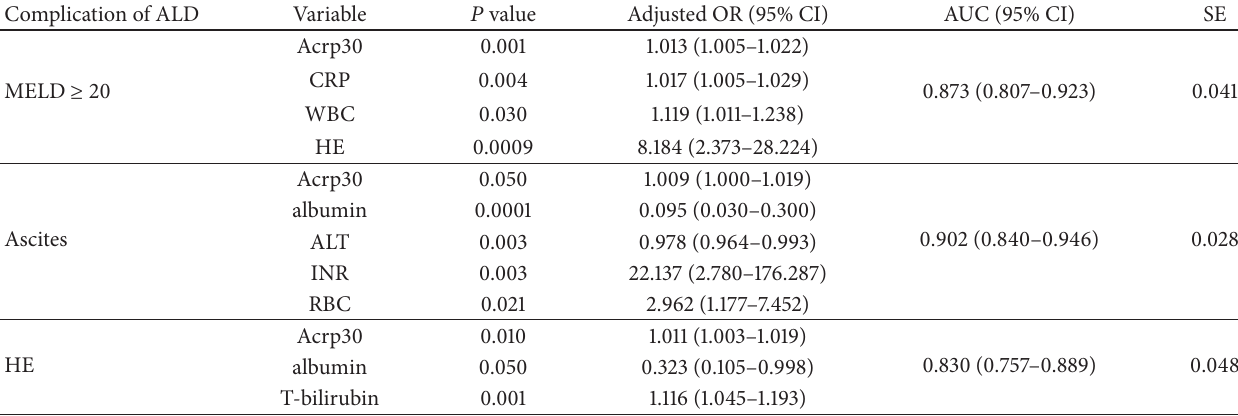
Table 12: Independent predictors of advanced liver dysfunction (MELD ≥ 20) and ALD complications (multivariable analysis) ∗